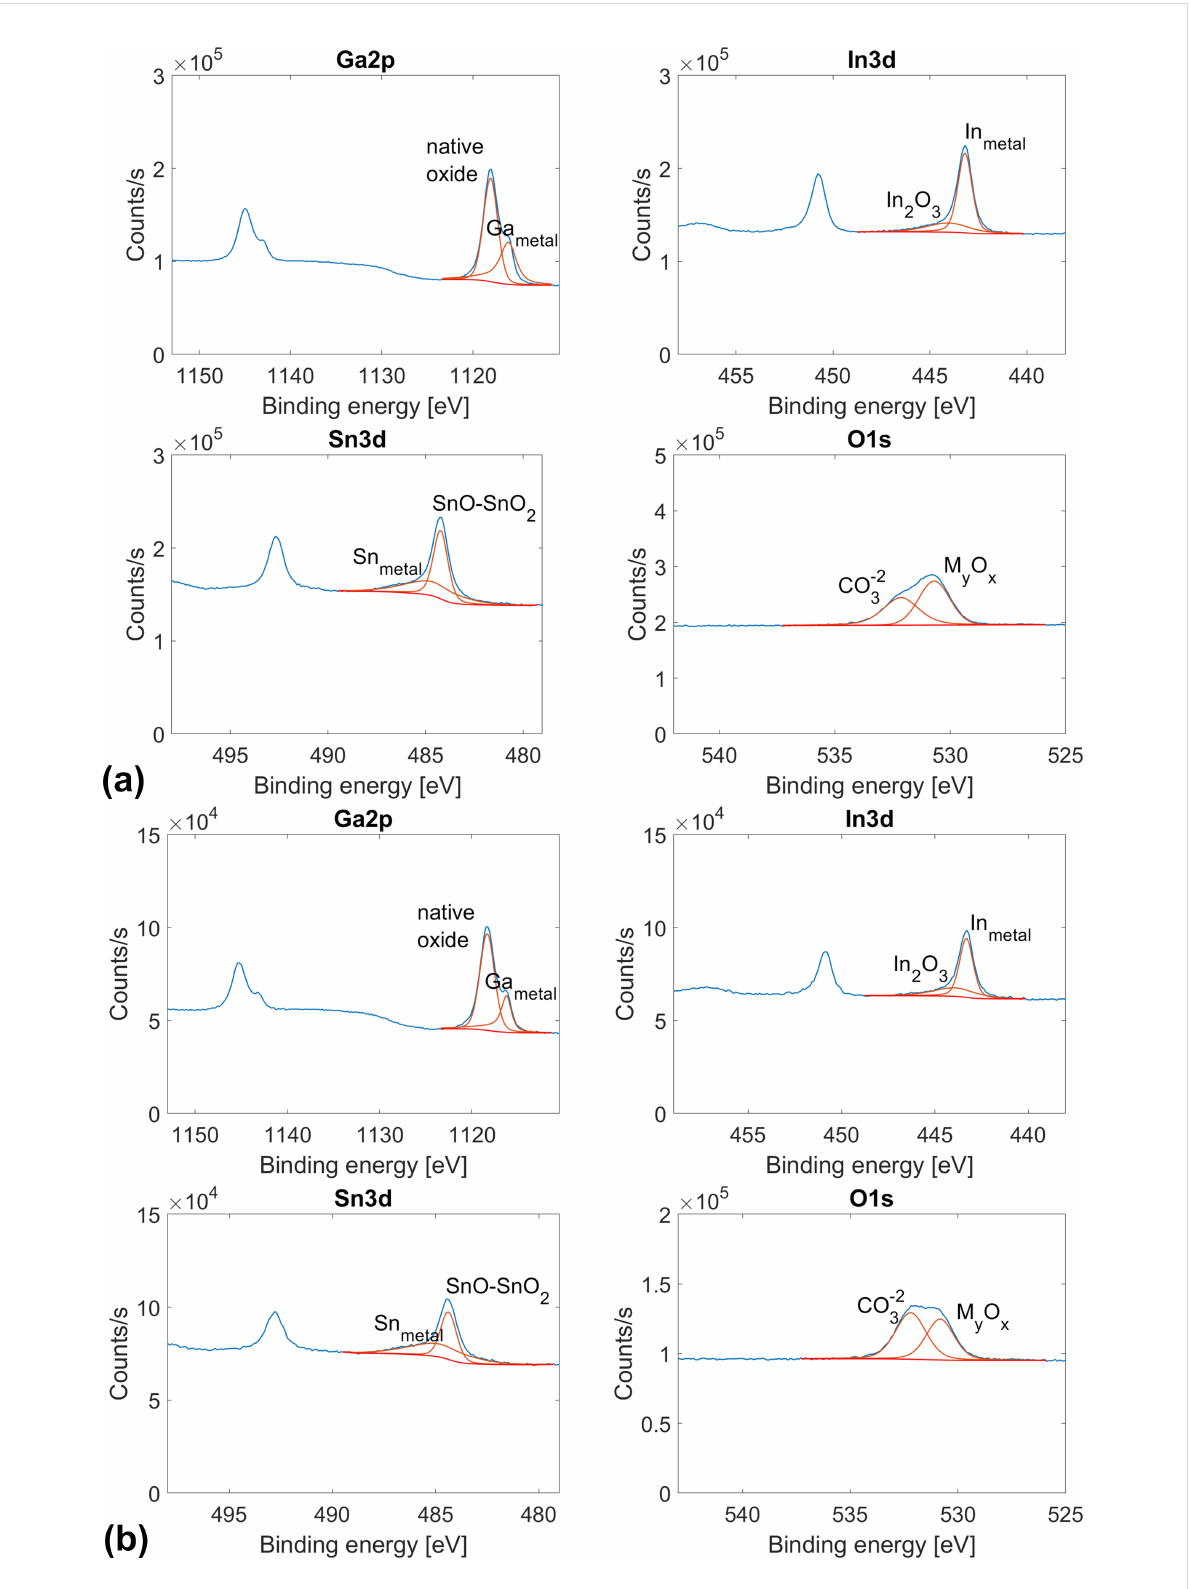
Figure 6: XPS results for the eutectic Ga–In–Sn melt (a) before and (b) after heating at 100 °C for 3